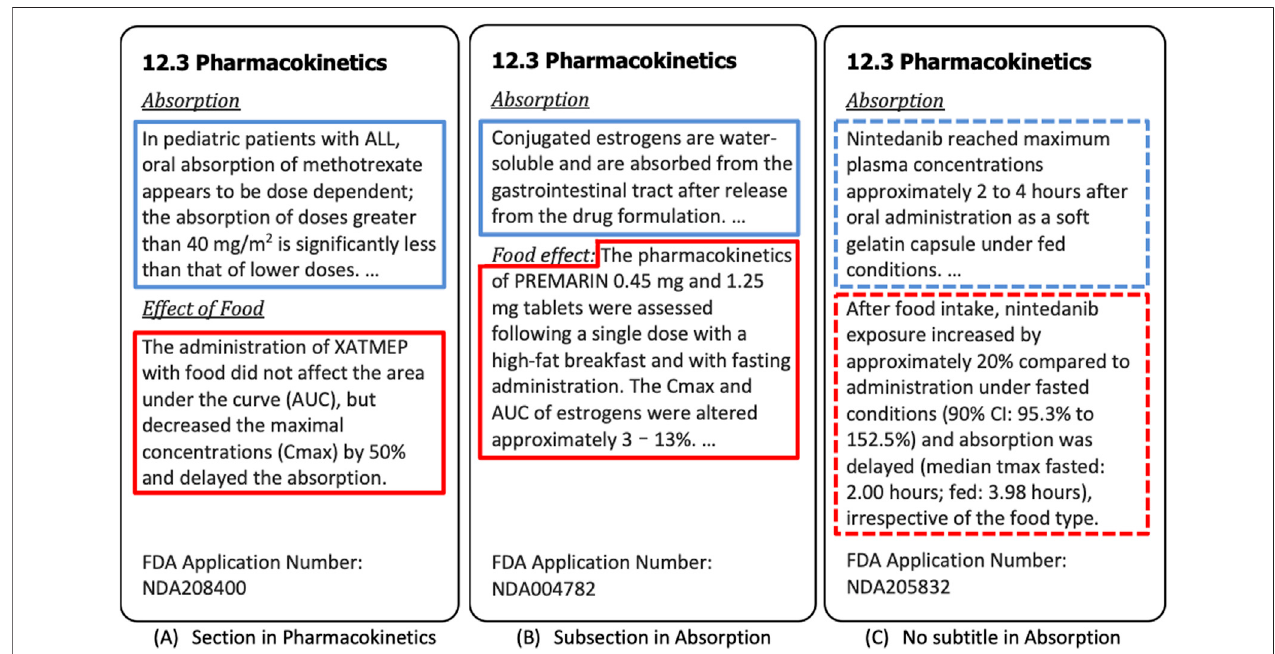
FIGURE3| ThreeExamplesofFoodEffectSection.In (A) and (B) ,theparagraphsintheblueborderareannotatedas “ Non-FoodEffect ” ,andtheparagraphsinthe redborderareannotatedas “ FoodEffect ” .In (C) ,theFoodEffectparagraphclassi fi cationmodelisabletoidentifytheparagraphintheblueborderas “ Non-FoodEffect ” , and the paragraphs in the red border as “ Food Effect ” . The dashed borders signify the paragraphs labeled by the model, whereas the borders in solid line represent the paragraphs automatically labeled by using regular expressions.